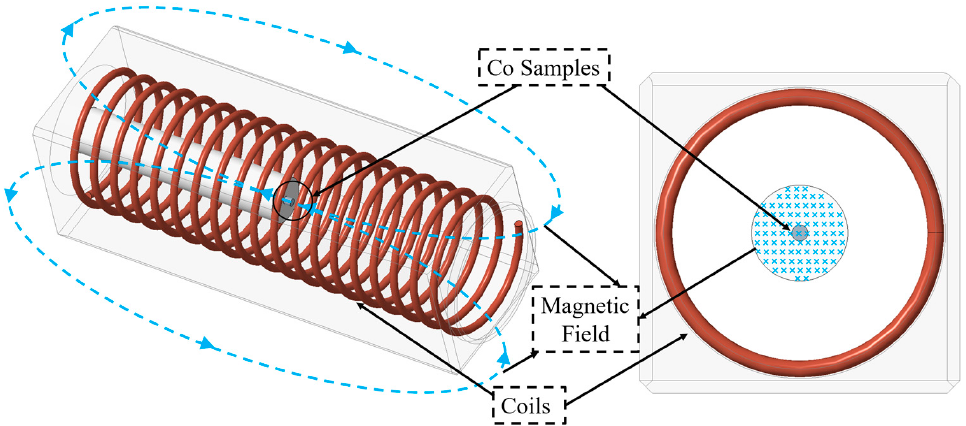
Figure 1. Principle of action of pulsed magnetic field treatment.